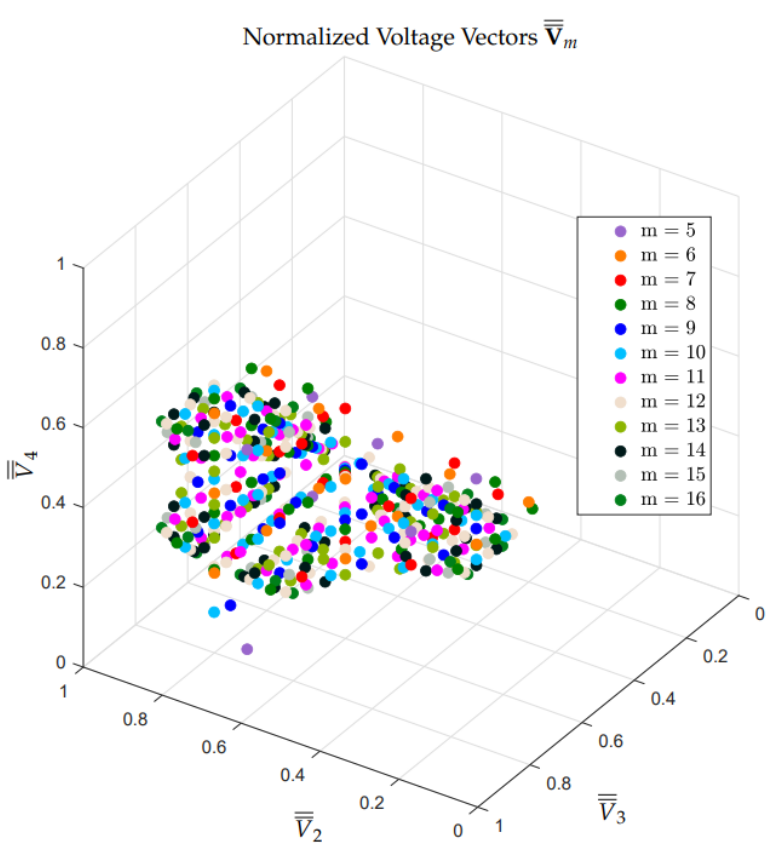
Figure 6. All of the Configuration Voltage Vectors V m , in normalized form V m , for the case n =